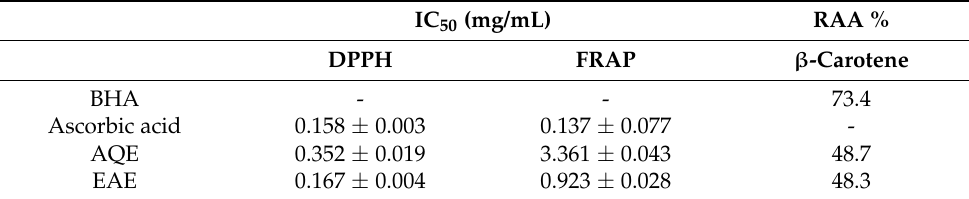
Table 2. The IC 50 values were obtained for the DPPH and FRAP tests, and the RAA% for the β -carotene bleaching test.